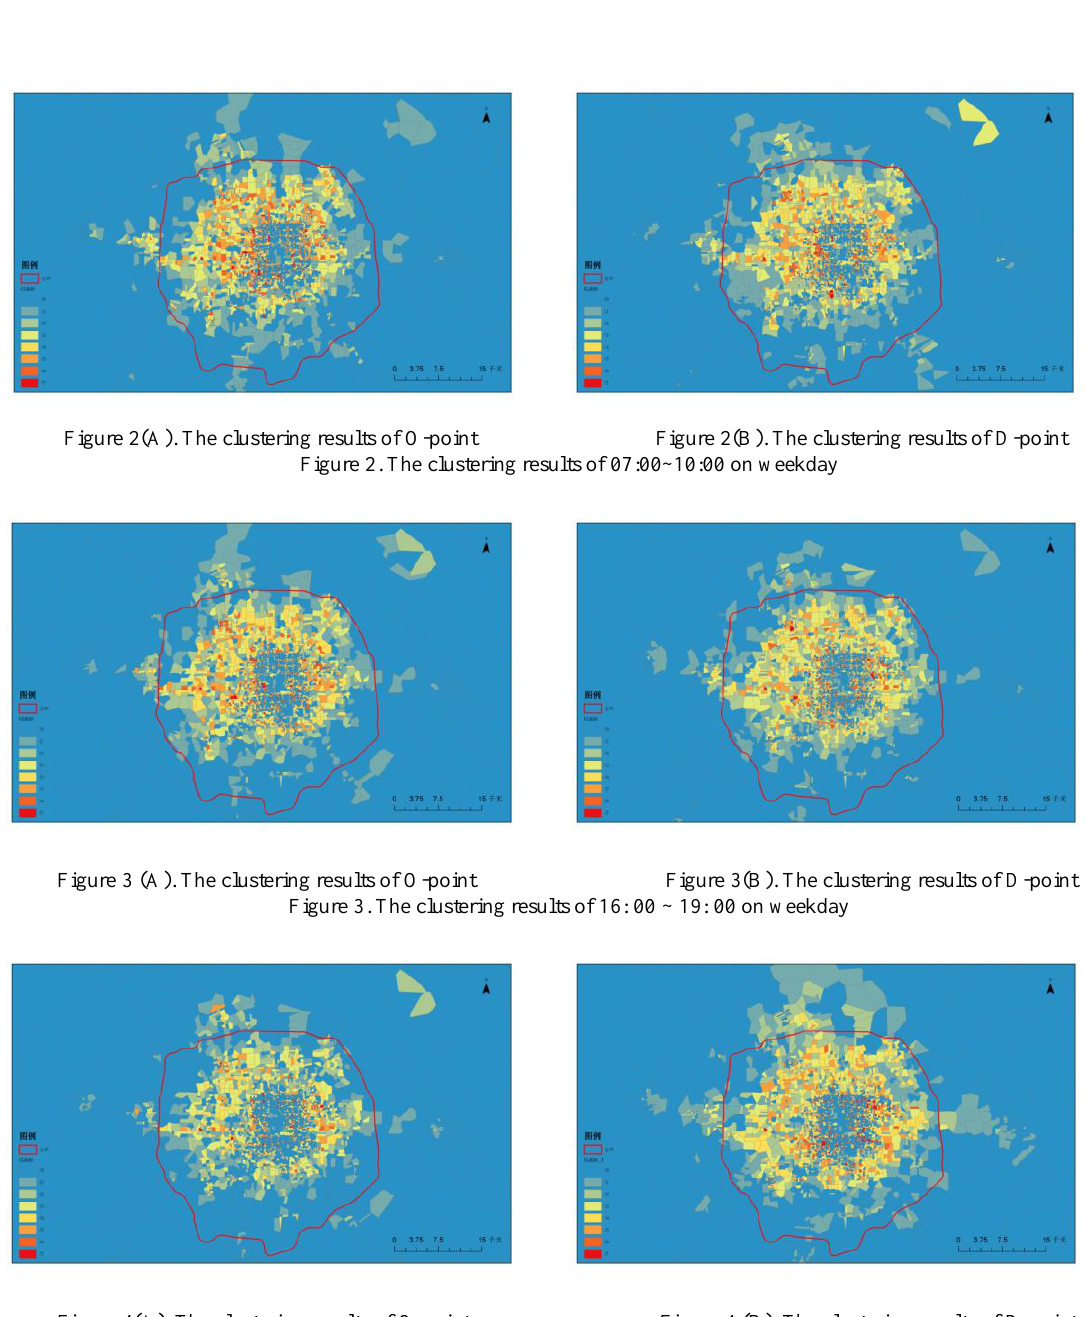
Figure 4(A). The clustering results of O-point Figure 4 (B). The clustering results of D-point Figure 4. The clustering results of 22:00~24:00 on